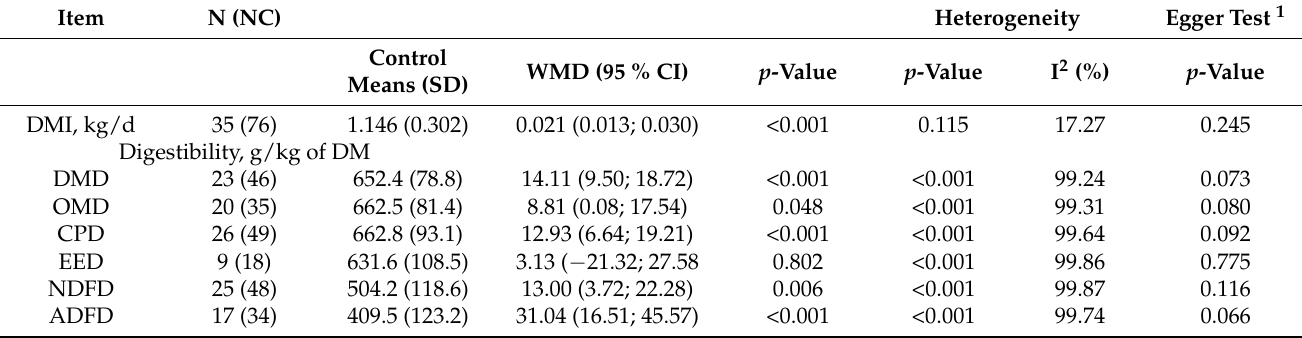
Table 2. Dry matter intake and nutrient digestibility of small ruminants supplemented with essential oils.